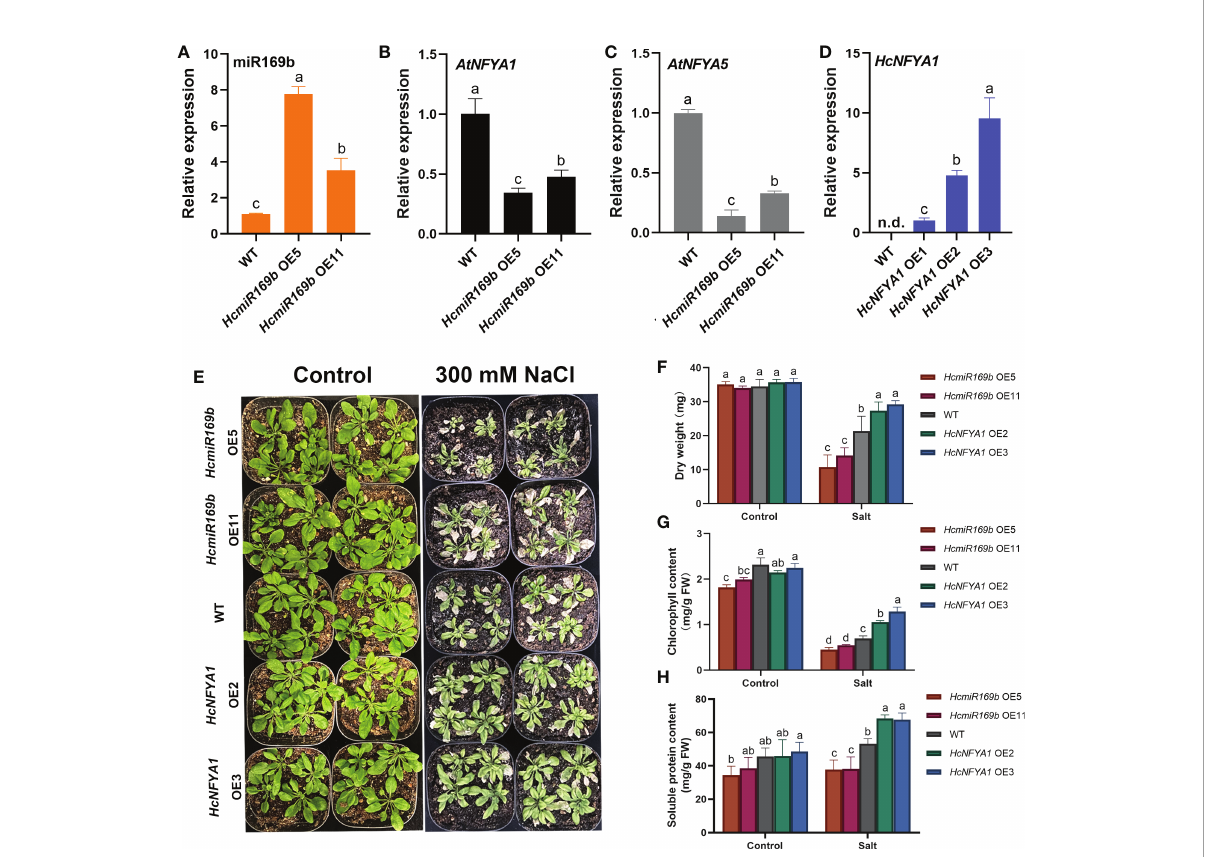
FIGURE 3 Functional analysis of Halostachys caspica miR169b/NFYA1 module under salt stress. (A-C) Relative expression of miR169b (A) , AtNFYA1 (B) and AtNFYA5 (C) in wild-type and HcmiR169b heterologous expressed Arabidopsis , the expression level of wild-type was adjusted to 1. (D) Relative expression of HcNFYA1 in wild-type and HcNFYA1 heterologous expressed Arabidopsis , adjusting the expression level of HcNFYA1 OE1 to 1. (E) Phenotype of adult Arabidopsis under 300 mM NaCl stress for 7 d. (F-H) The aboveground dry weight (F) , chlorophyll content (G) and soluble protein content (H) of Arabidopsis under salt stress. Values for aboveground dry weight represented the means ± SD of 10 biological replicates, and values for other data represented the means ± SD of three biological replicates. Different letters indicated signi fi cant differences in the detected values of various types of Arabidopsis between treatments (Duncan ’ s multiple range test, p